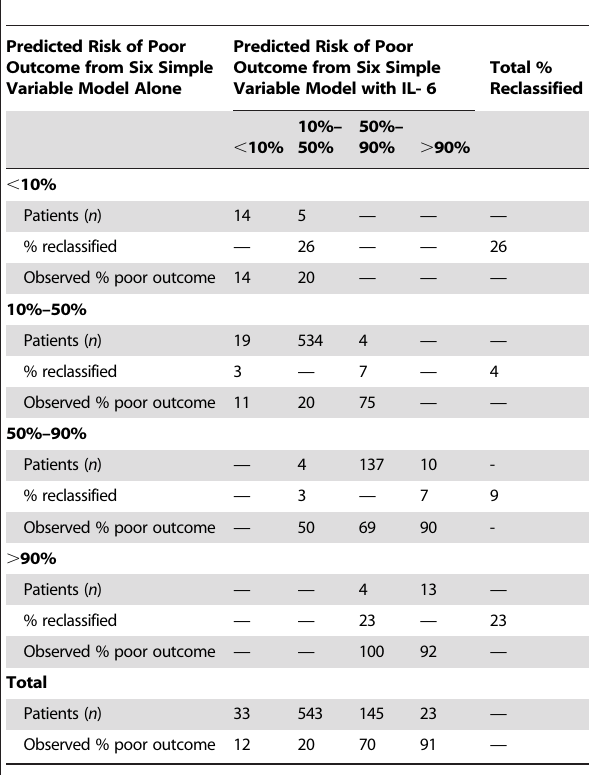
Predicted Risk of Poor Outcome from Six Simple Variable Model Alone